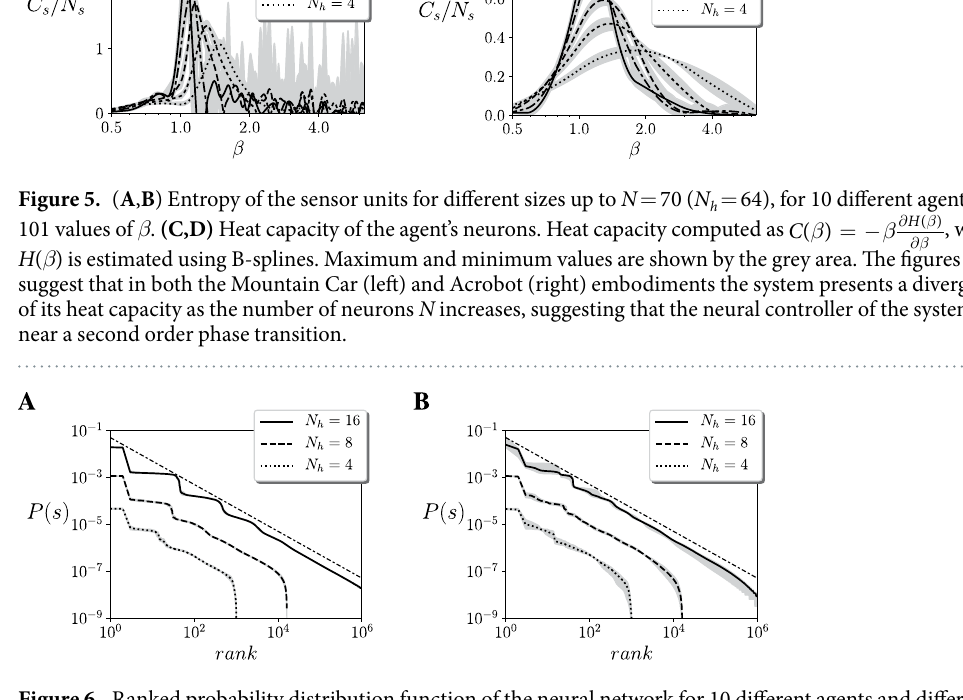
Figure 6. Ranked probability distribution function of the neural network for 10 different agents and different sizes in (A) the Mountain Car and (B) the Acrobot embodiments. The real distribution is compared with a distribution following Zipf’s law, (i.e. P ( s ) = 1/ rank , dash-dotted line). We observe a good agreement between the model and Zipf’s law, suggesting critical